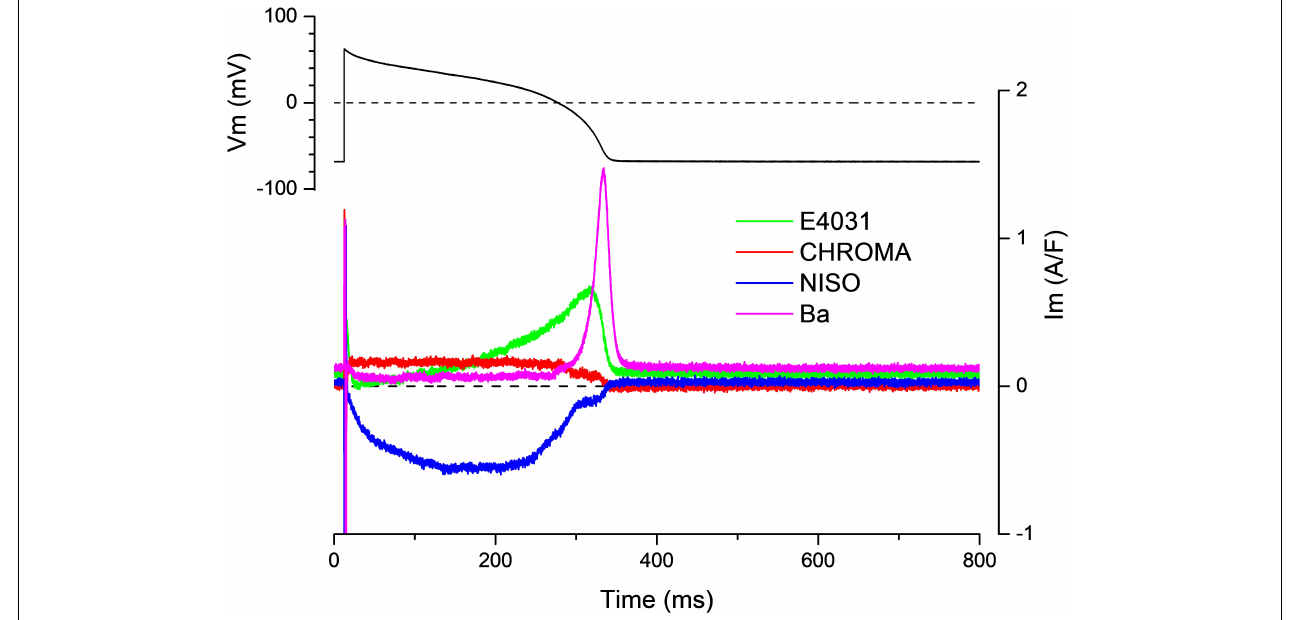
FIGURE 3 | Onion-peeling recording of multiple currents in the guinea pig ventricular myocyte. Representative current